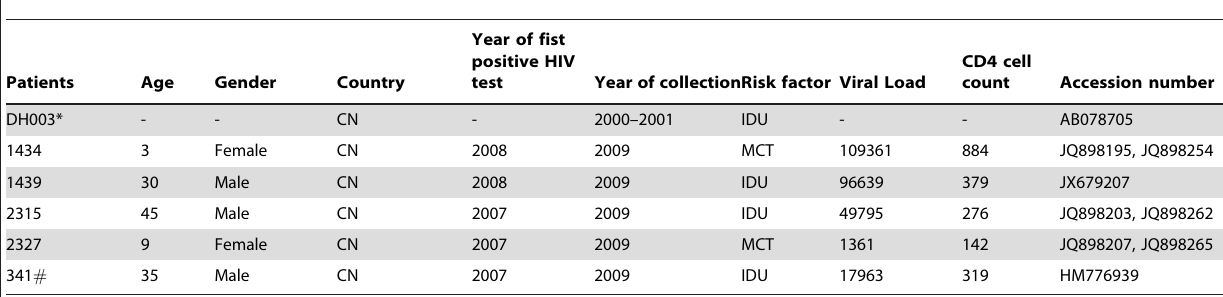
Table 3. Information on subjects harboring novel B 9 /C recombinants in Yunnan China.